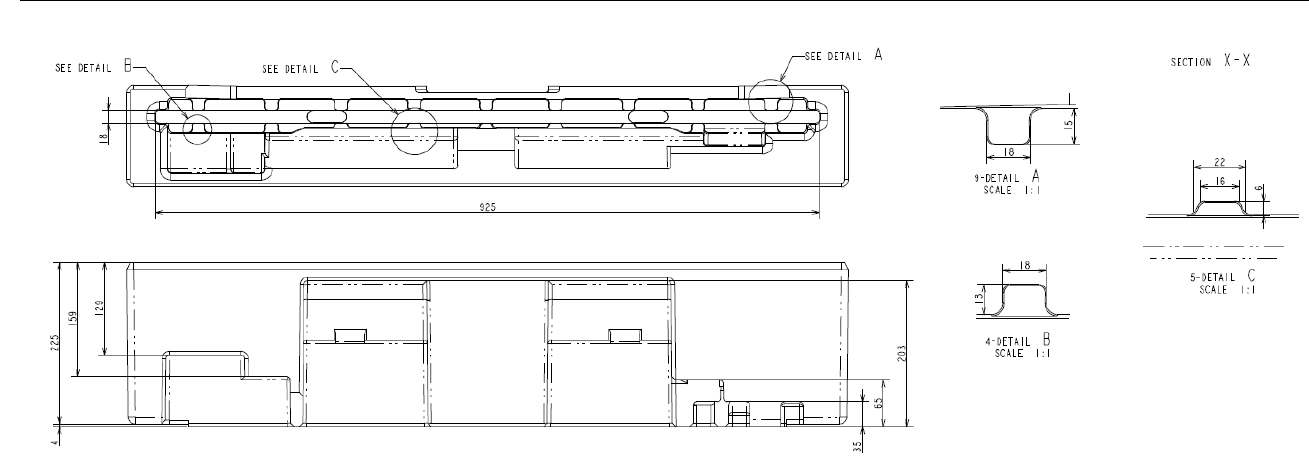
Figure 14. Dimension of rib.